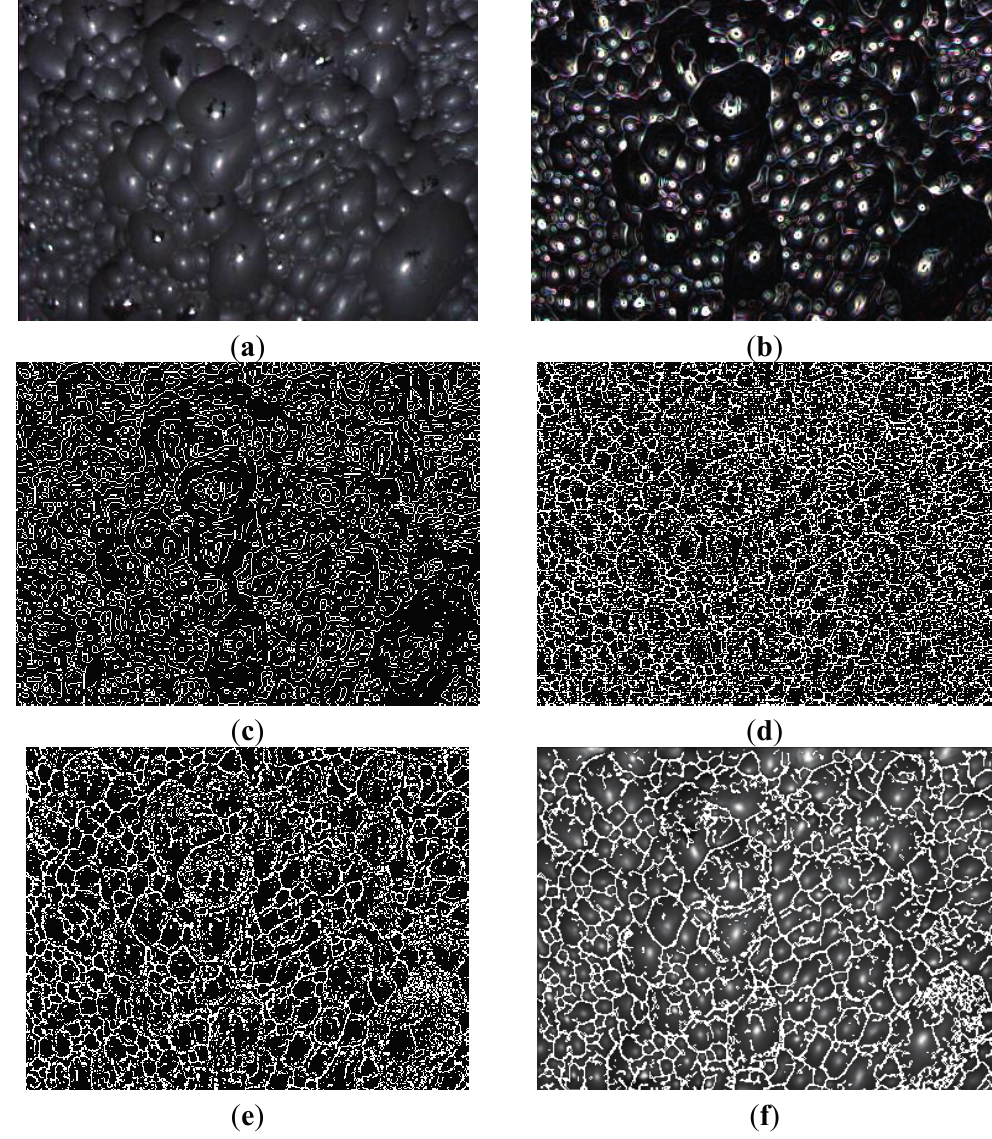
Figure 12. Comparison between the proposed edge detection algorithm and others (for the image of large bubbles). ( a ) Original image; ( b ) Sobel result; ( c ) Canny result; ( d ) Valley-edge result; ( e ) New algorithm result; ( f ) Result of overlap (e) and (a). After edge detection by the improved local gray value minima algorithm, the post-processing procedures can be done on the froth edge images to obtain the final good image segmentation